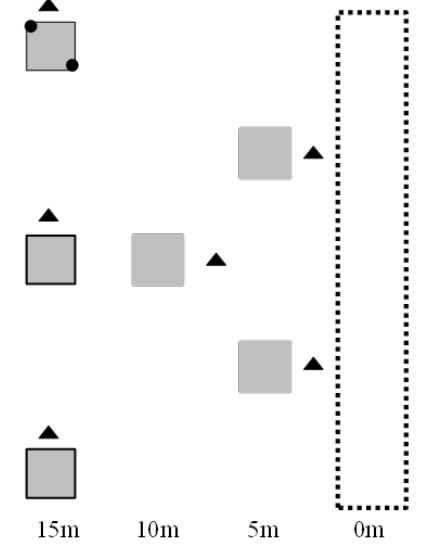
Figure 1. Sampling design for testate amoebae, plants and environmental variables. Distances (m) refer to distances of the 1m² plots from ditches at the Ditched and Restored sites. At Natural sites, a similar arrangement of plots was used.